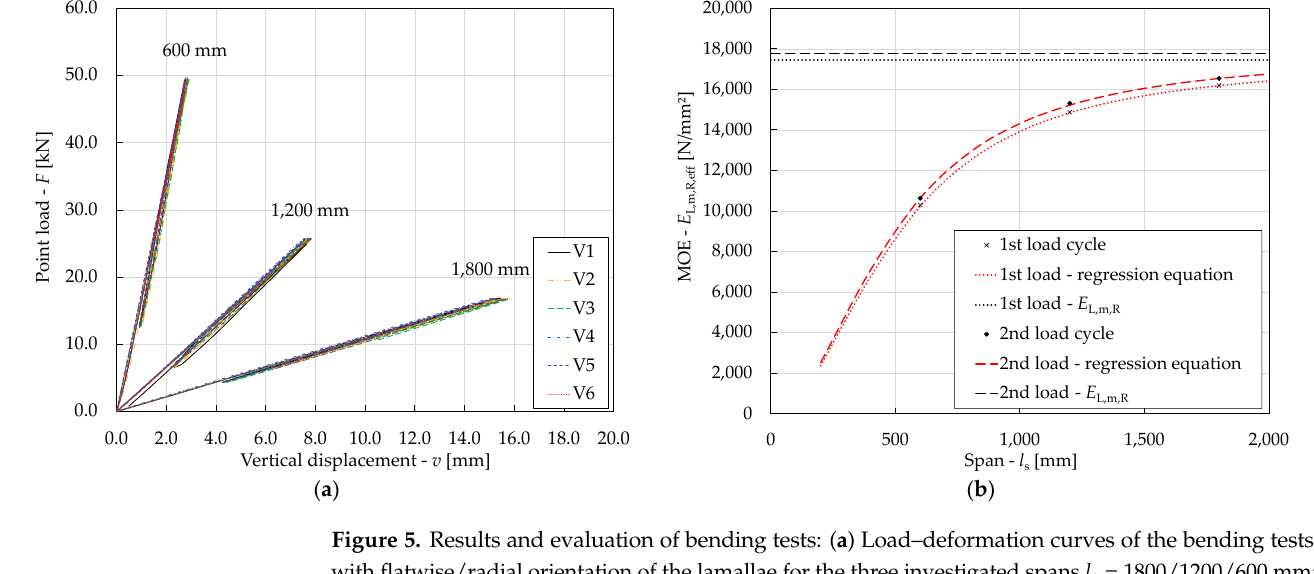
Figure 5. Results and evaluation of bending tests: ( a ) Load–deformation curves of the bending tests with flatwise/radial orientation of the lamallae for the three investigated spans l s = 1800/1200/600 mm; ( b ) Evaluation of the bending test BR_V2 with flatwise/radial orientation of the lamallae; effective MOE E L,m,R,eff , regression curve and MOE E L,m,R depending on the span l s for both load cycles.